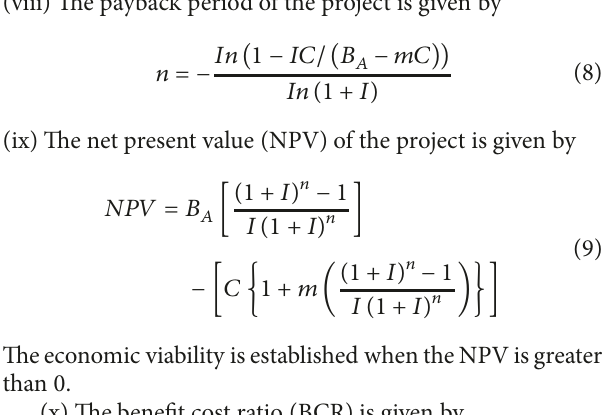
Table 13: Economic parameterfor biomass gasificationpowerplant.